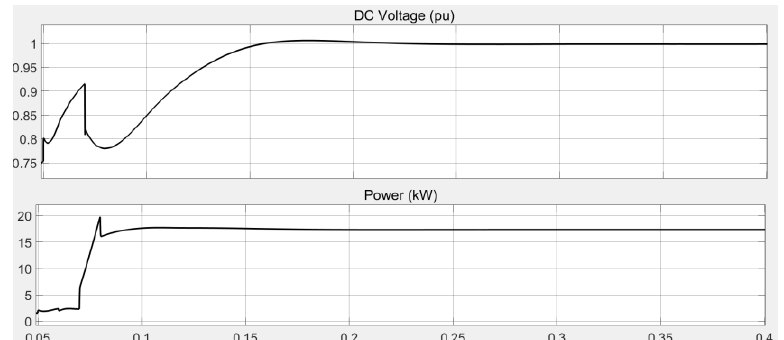
Figure 4. Signals at DC bus.